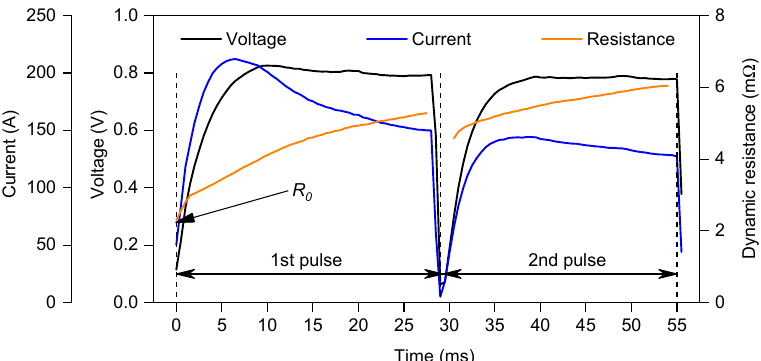
Figure 2. Curves of voltage, current and dynamic resistance collected in a welding process.